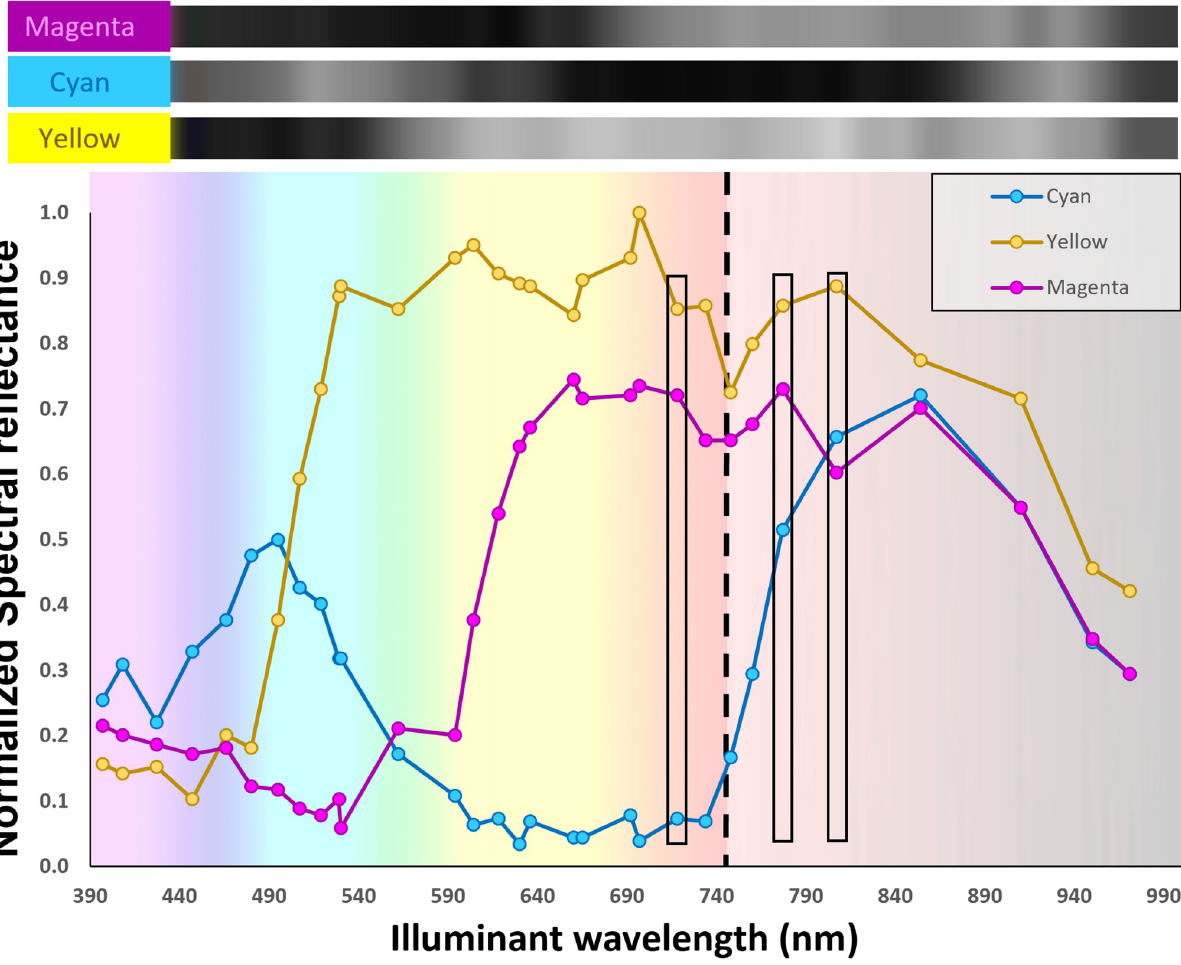
Fig 4. Spectral reflection analysis of cyan, magenta, and yellow inks illuminated with 31 LED channels spanning visible to near-infrared illumination. Images of each dye were captured by a monochromatic camera and grayscale reflectance intensity sequentially arrayed in the top inset.